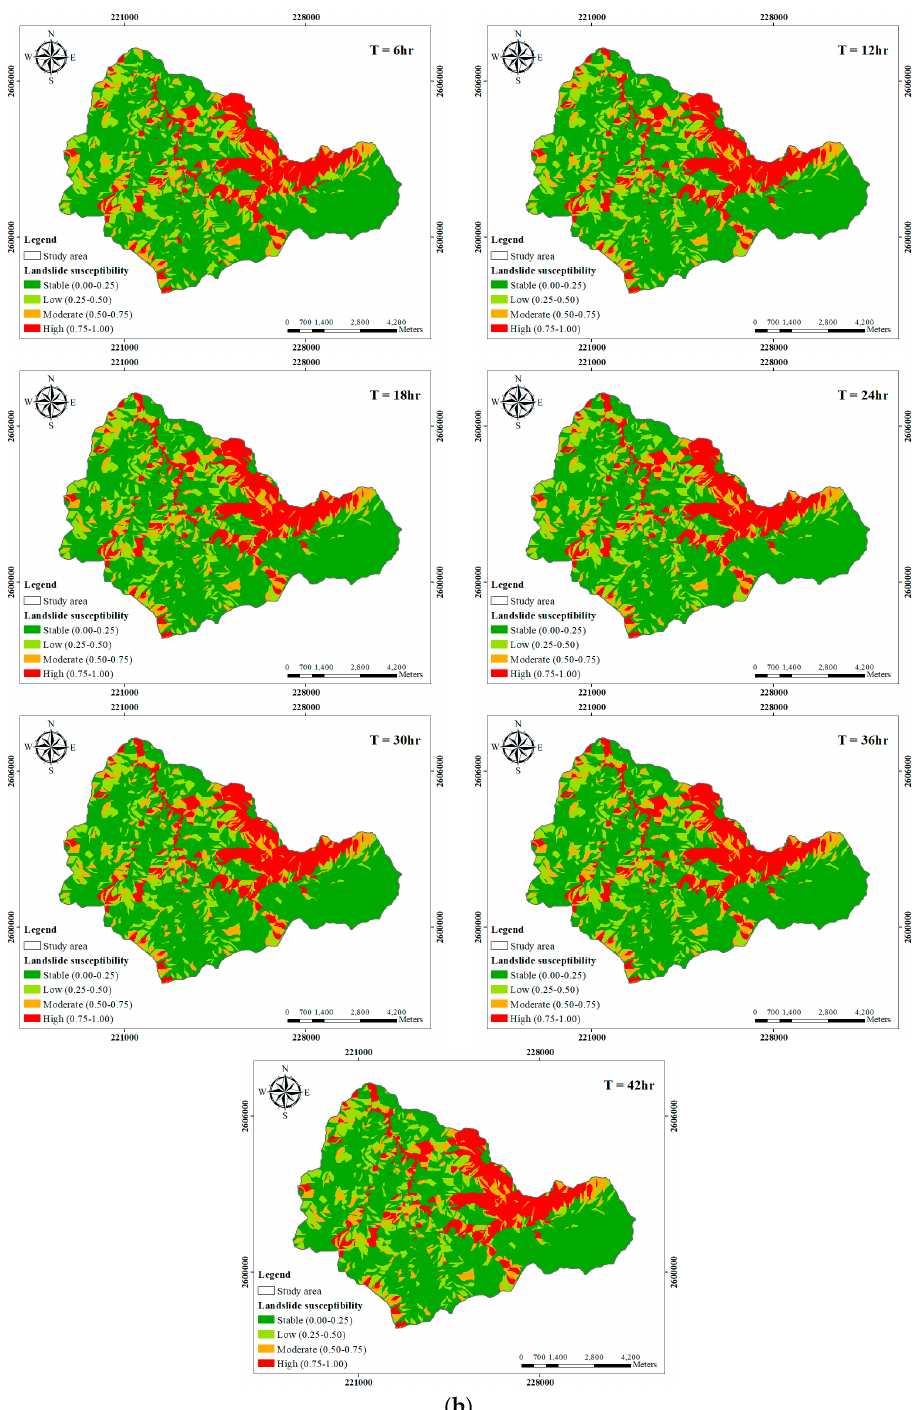
Figure 7. Variations of predicted susceptibility levels with respect to the rainfall durations: ( a ) Typhoon Talim and ( b ) Typhoon Jangmi. Talim and ( b ) Typhoon